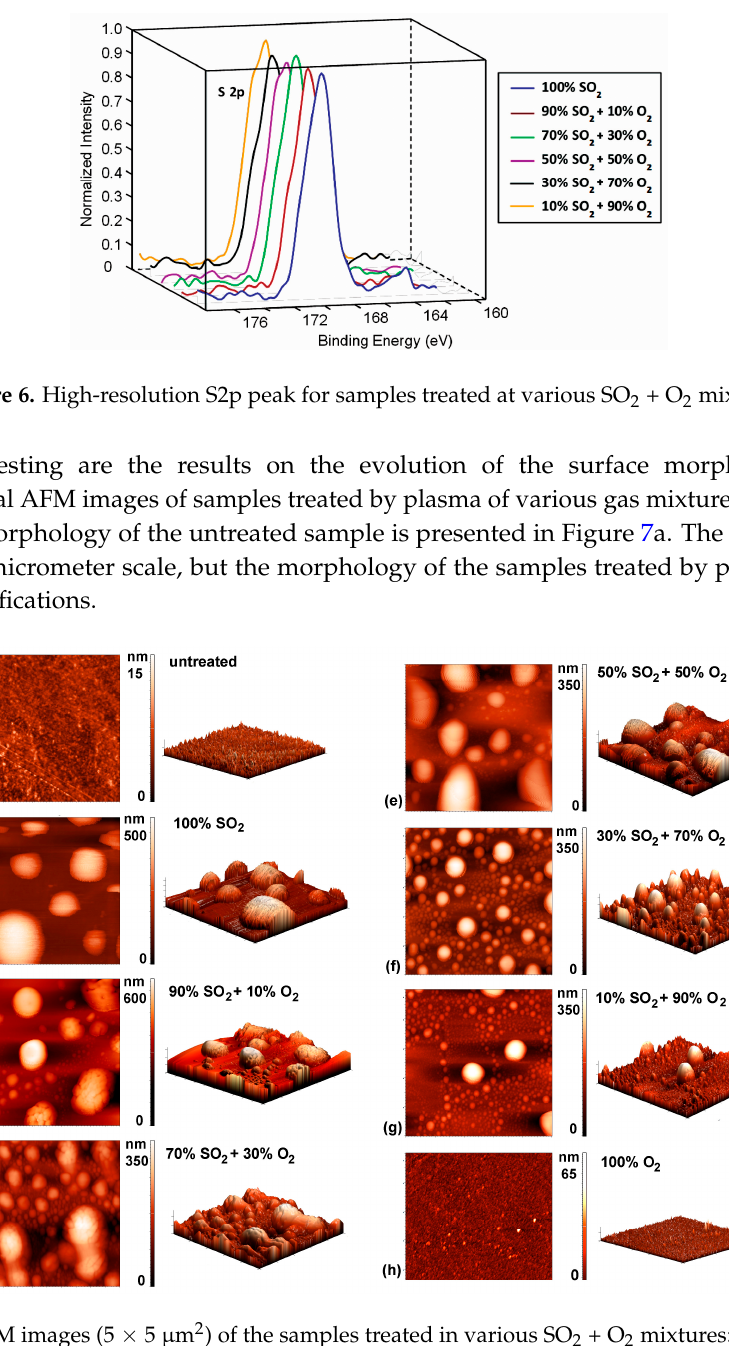
Figure 5. High-resolution C1s peak for samples treated at various SO 2 + O 2 mixtures.